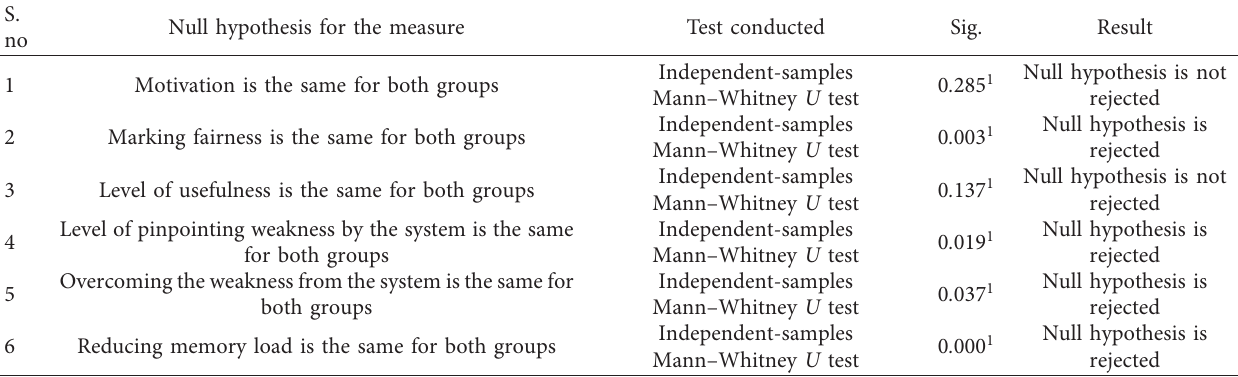
Figure 10: Effectiveness. Table 12: Analysis of model’s